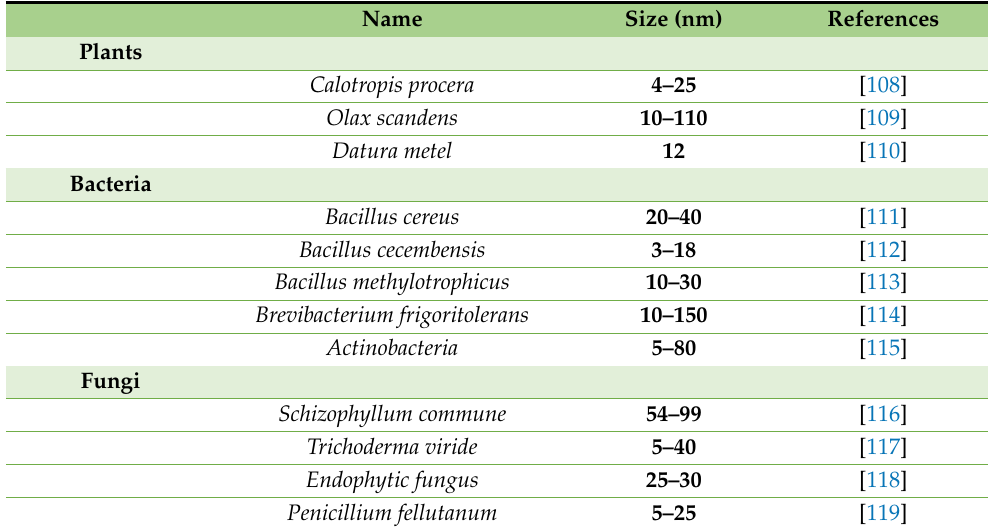
Table 3. Green synthesis of silver spherical nanoparticles using, as a silver precursor, AgNO 3 .